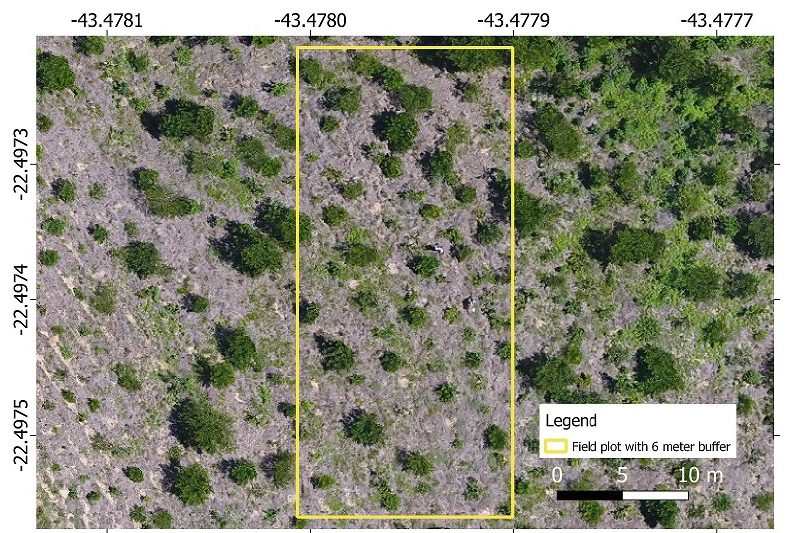
Figure 4. There are at least six different tree species in the rectangle area, but all of them are very similar, and none could be distinguished by